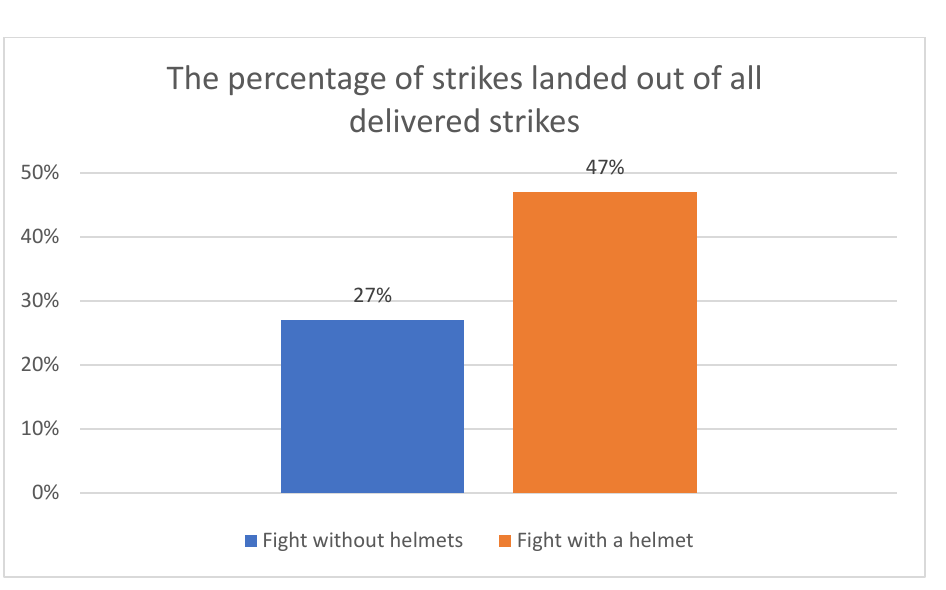
Table 3. Descriptive and comparative statistics of fights with and without a helmet in relation to hand techniques.